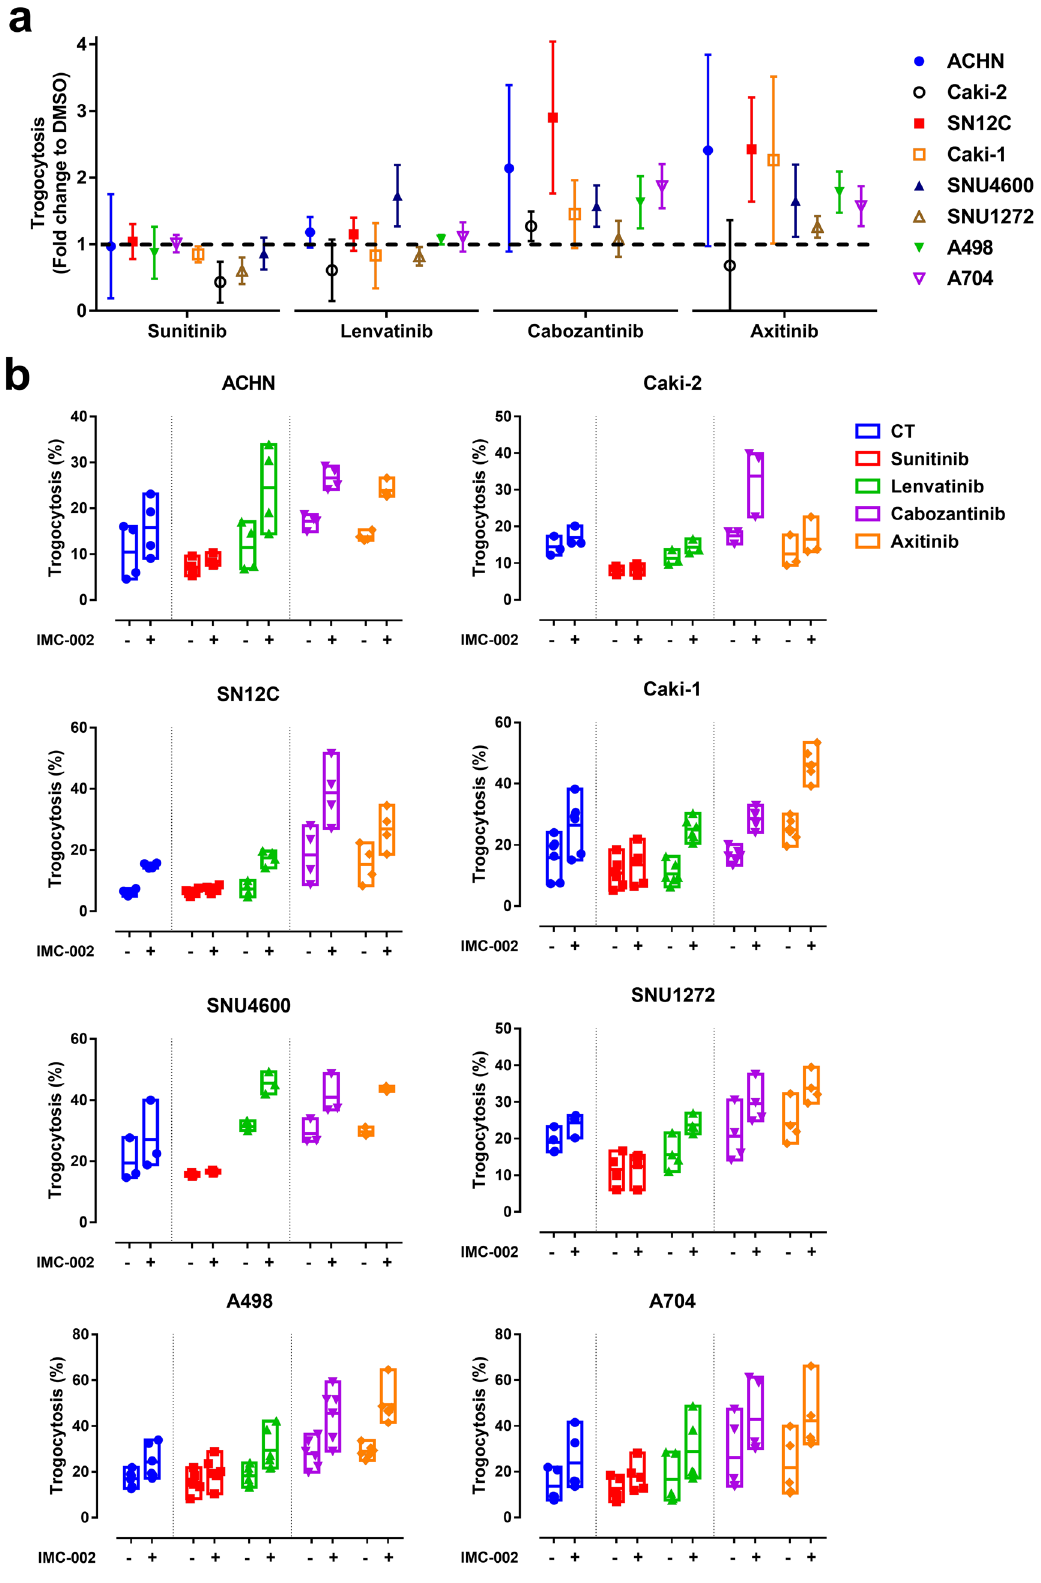
Figure 4. VEGFR TKIs affect the susceptibilities of RCC cell lines to macrophages. ( a ) Graph summarizing the fold change of altered trogocytosis by each VEGFR TKI in all RCC cell lines for each drug (n = 4). All RCC cells were exposed to each VEGFR TKI at a concentration of 10 μM for 24 h before the phagocytosis assay. ( b ) Trogocytosis (%) analysis of macrophages cocultured with each RCC cell line exposed to each VEGFR TKI for 24 h in the presence of IgG4 isotype control or IMC-002 (n = 3 ~ 5). Phagocytosis assay was analyzed using flow cytometry after coculture of tumor cells and macrophages for 2 h at an E:T ratio of 1:1. Dimethyl sulfoxide solution was used as a